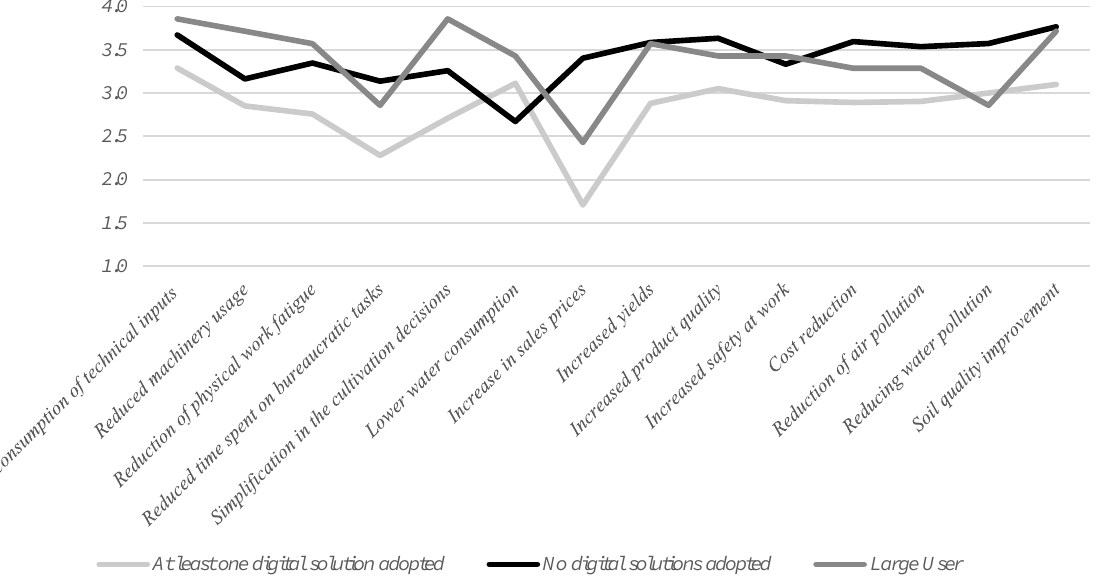
Figure 11. Benefits of Agri 4.0 solutions.